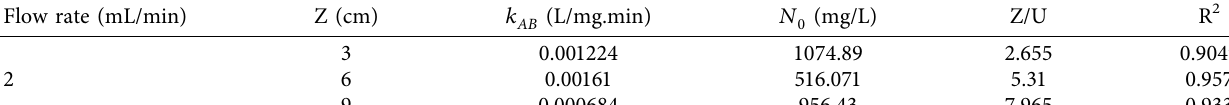
Table 5: Kinetics of the Adams–Bohart model for cadmium removal. Flow rate (mL/min)